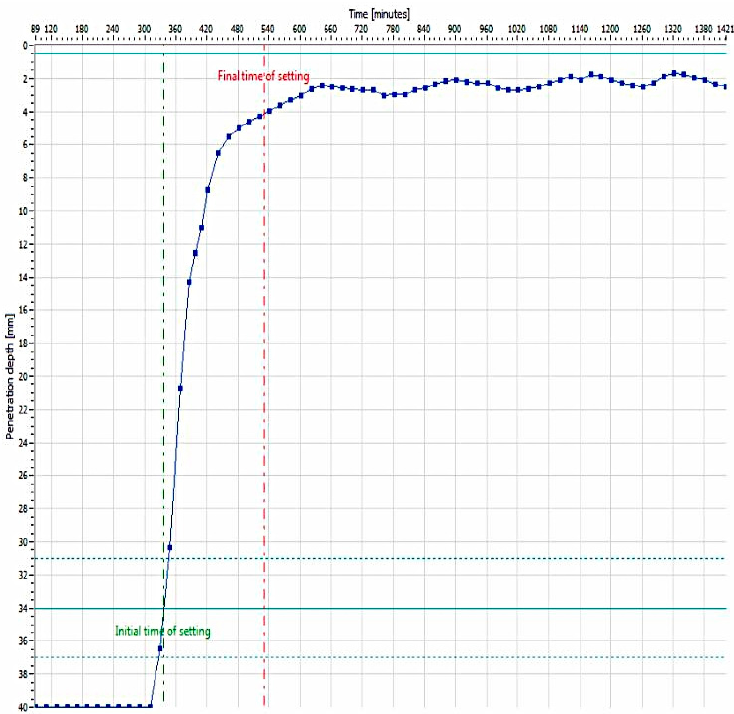
Figure 11. The setting process of the cement slurry based on CEM I 42.5R Portland cement (long transition time); Composition No. 1. transition time); Composition No.